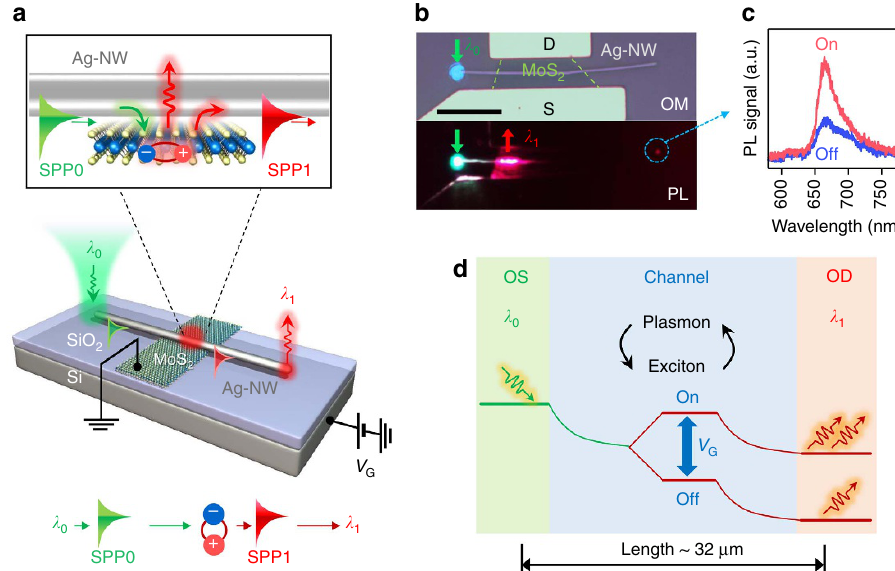
Figure 2 | Long channel exciton transistor. ( a ) A long Ag-NW overlapped on the MoS 2 FET. The incident l 0 is converted to SPP0. The SPP0 propagating along the NW is absorbed in MoS 2 , and the l 1 exciton is generated at the NW/MoS 2 overlapping region. The l 1 is recoupled to SPP1 near the NW and scattered out at the right end of the NW. The l 1 flux is modulated by V G . ( b ) Optical micrograph overlaid with false-coloured MoS 2 flakes (top) and PL image (bottom) of the exciton transistor. Source (S) and drain (D) for electrodes of the FET. Green arrow: l 0 position. Red arrow: l 1 emission. Blue dashed circle: PL collection position. Scale bar: 10 m m. ( c ) PL spectra for On ( (cid:2) 100V) and Off (100V) states. ( d ) Schematic depicts the transistor operation. Optical source (OS): l 0 input. Optical drain (OD): l 1 output. Channel: NW and NW/MoS 2 overlapping region. NATURE COMMUNICATIONS|7:13663|DOI: